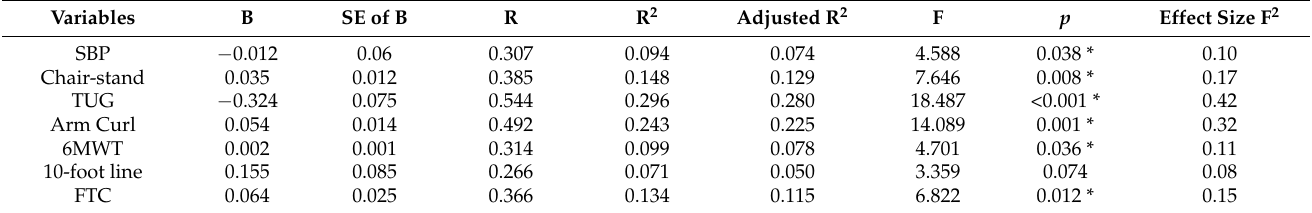
Table 4. Values of the regression analysis explaining phase angle values for th overall